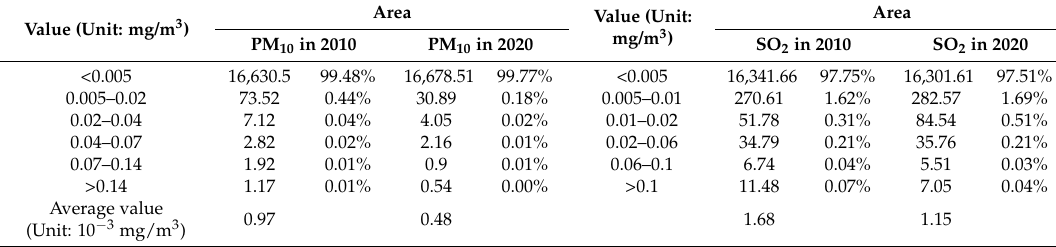
Figure 4. Classification maps of the SO 2 and PM 10 concentrations of Lianyungang in 2010 and 2020. Table 3. Areas of SO 2 and PM 10 concentrations at different levels in 2010 and 2020.